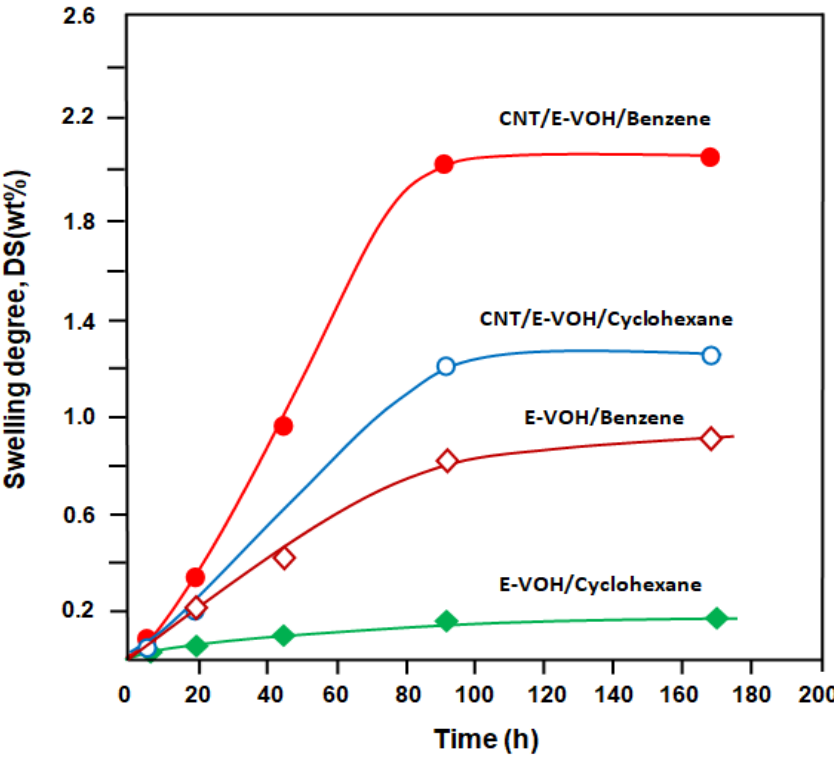
Figure5. VariationsintheswellingdegreesofpureE-VOHandCNT / E-VOHnanocompositemembranes Figure 5. Variations in the swelling degrees of pure E-VOH and CNT/E-VOH nanocomposite vs. time in benzene and cyclohexane at 25 ◦ C. membranes vs. time in benzene and cyclohexane at 25 °C.